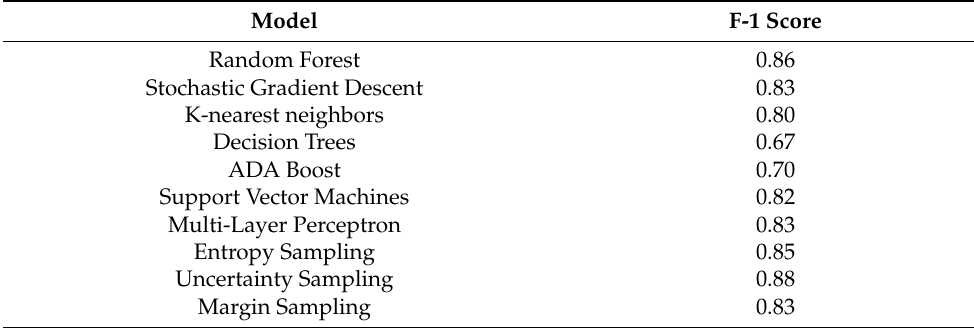
Table 5. F-1 scores of supervised and active learning